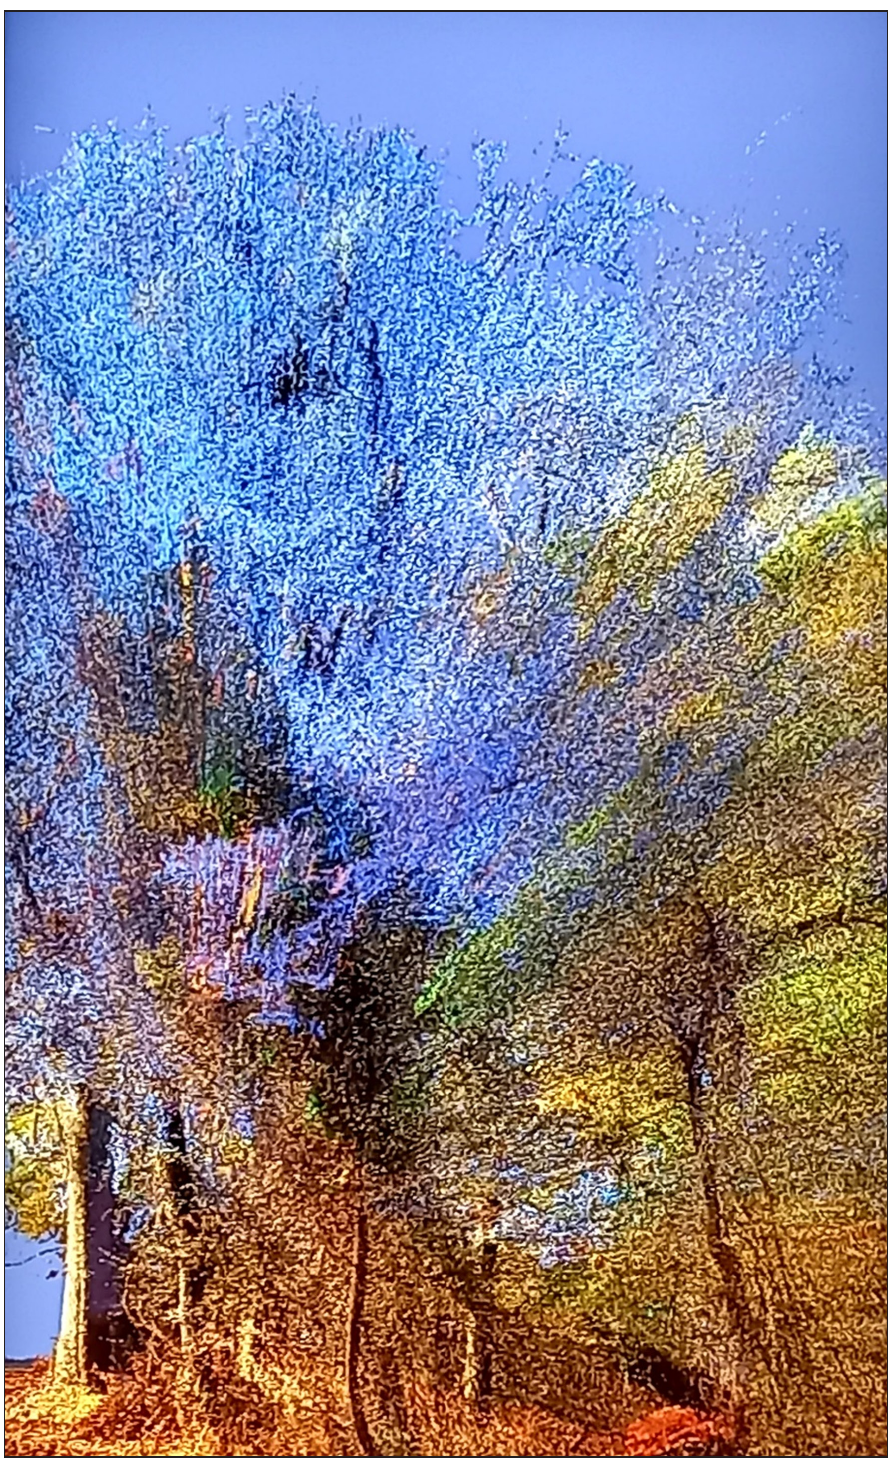
Figure 4: Davide Quayola. Pointillism, 2021. Photo Susan Broadhurst, 29 th September,